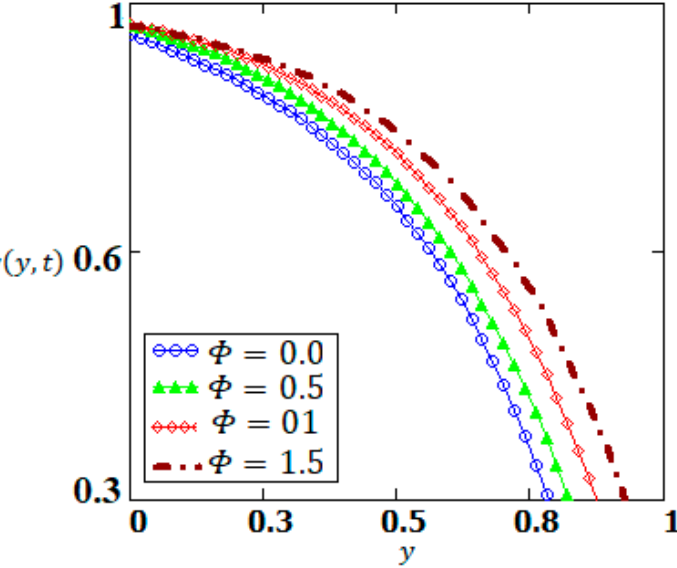
Figure 5. Effective role of velocity field depicted from Equation (19) for Φ .